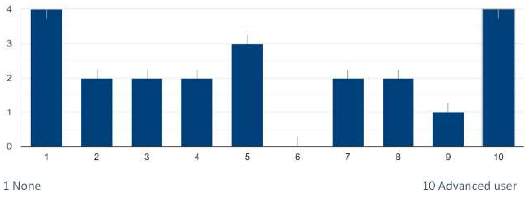
Figure 7: Distribution of computer gaming skills by participants.